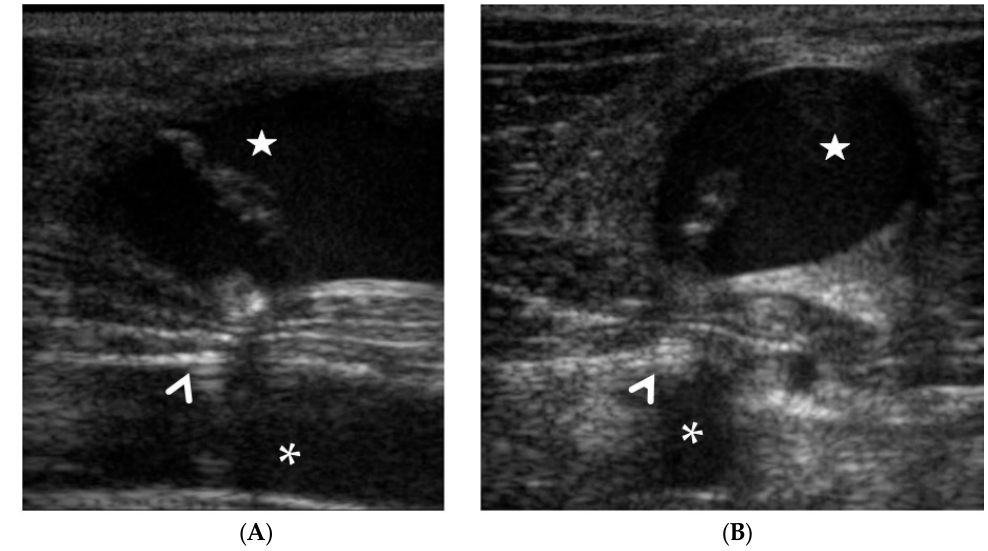
Figure 7. Case 5. Longitudinal ( A ) and transverse ( B ) ultrasound showing incorrect deployment of the Angio-Seal system (arrowhead): the jugular vein (star) was inadvertently pierced by the introducer during percutaneous ultrasound-guided carotid (asterisk)